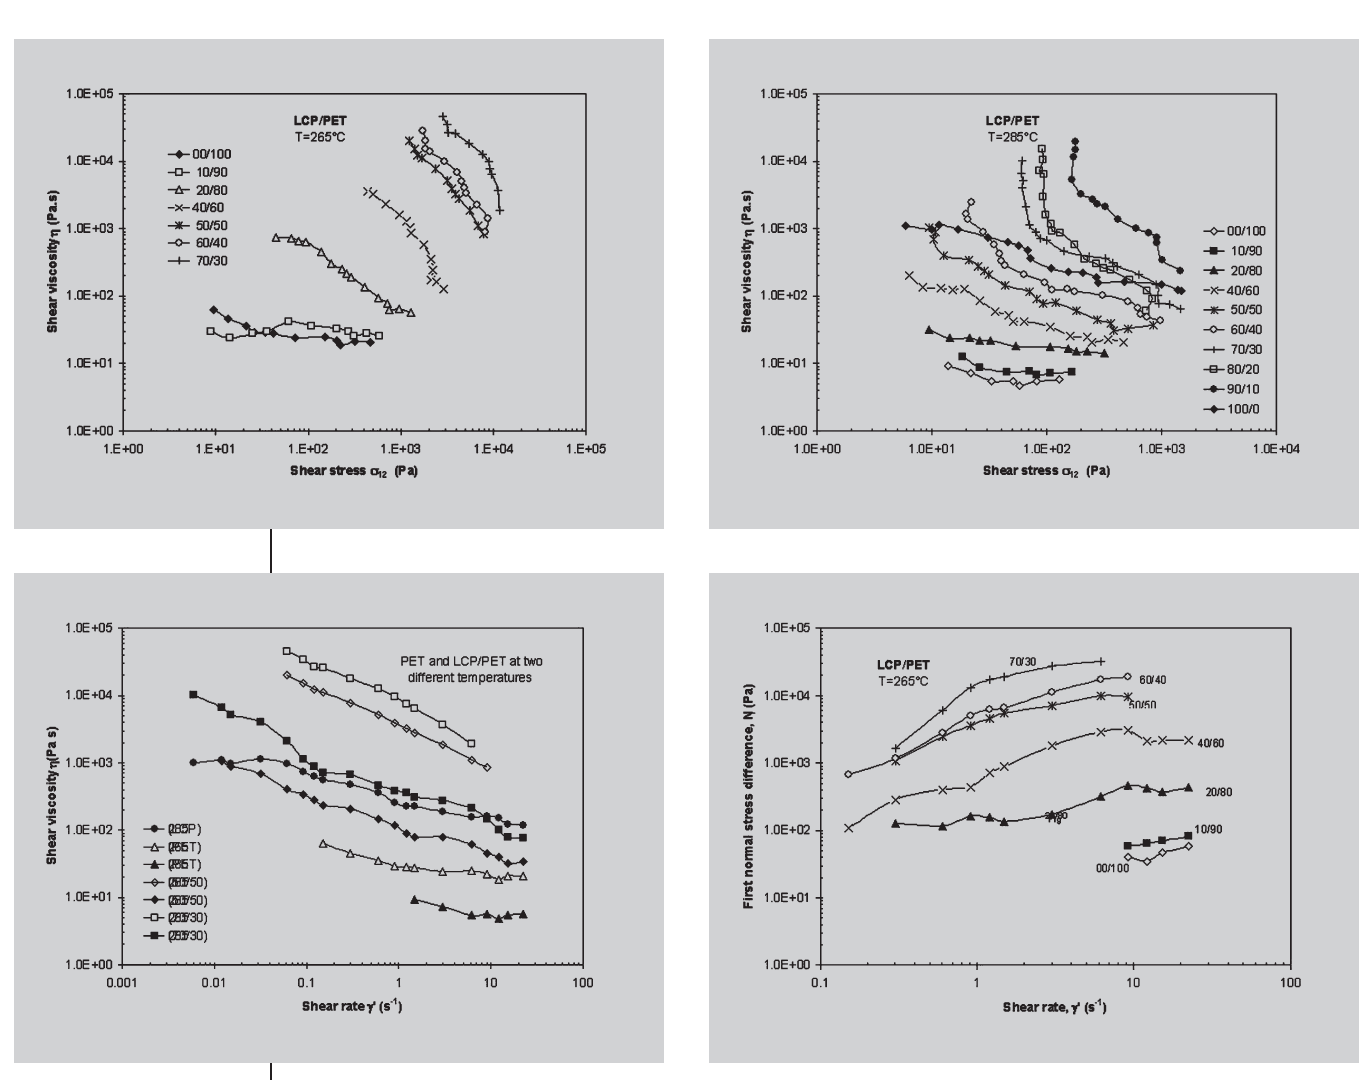
Figure 7 (left above): Plots between shear viscosi- ty and shear stress at 265°C for LCP/PET blends. Figure 8 (right above): Plots between shear viscosi- ty and shear stress at 285°C for LCP/PET blends. Figure 9 (left below): Plots between shear viscosi- ty and shear rate at 265°C and 285°C. Figure 10 (right below): Variation in first normal , of stress difference,N 1 LCP/PET blends with shear rate at